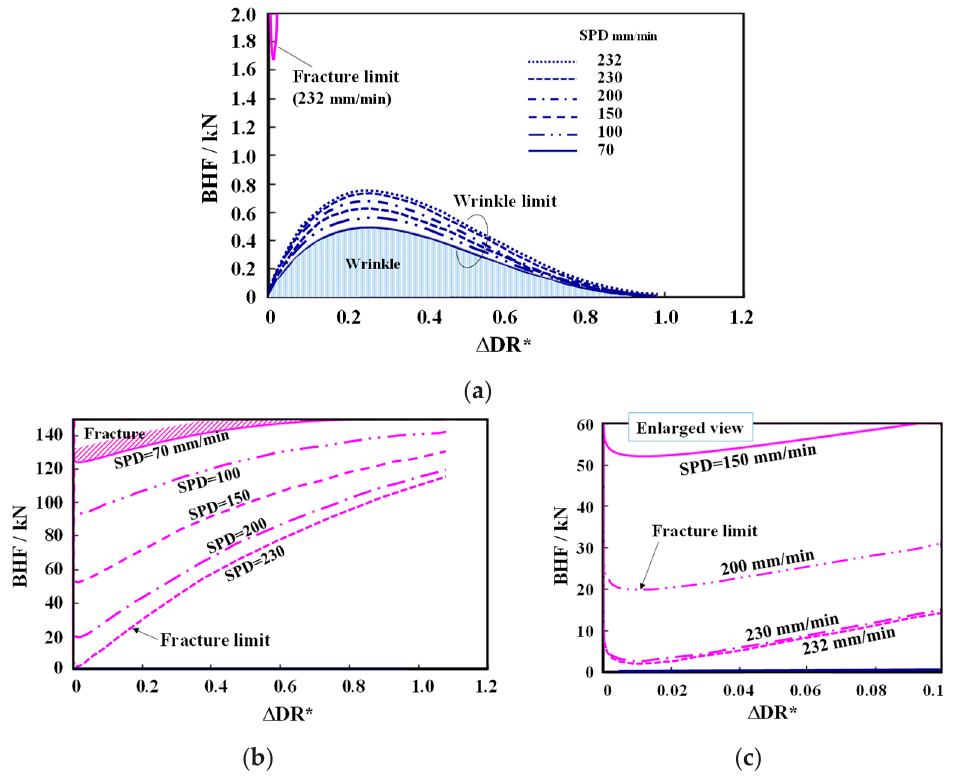
Figure 10. Theoretical wrinkle limit and fracture limit diagram for the superplastic warm deep drawing process. ( a ) Wrinkle limit BHF, ( b ) fracture limit BHF, ( c ) fracture limit BHF (enlarged view).